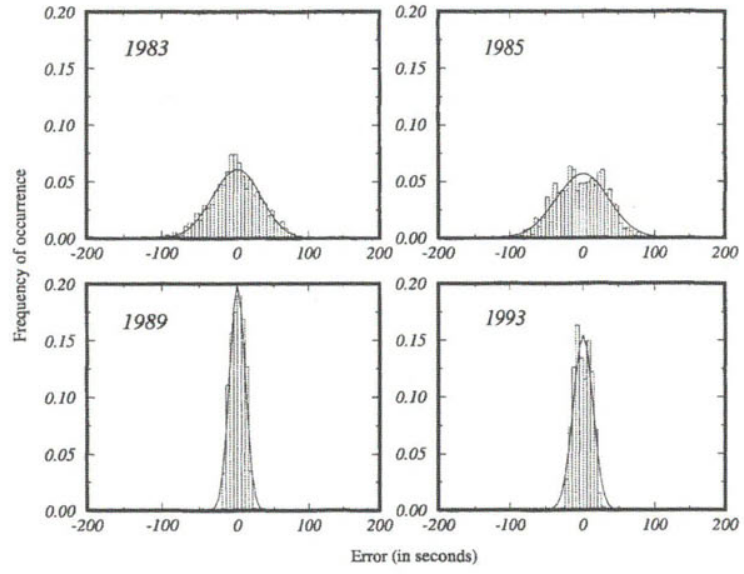
Fig. 2. Error distributions obtained from Monte Carlo simulations for estimates of the phase of the 516 s pulsation for four different data sets (number of simulations: